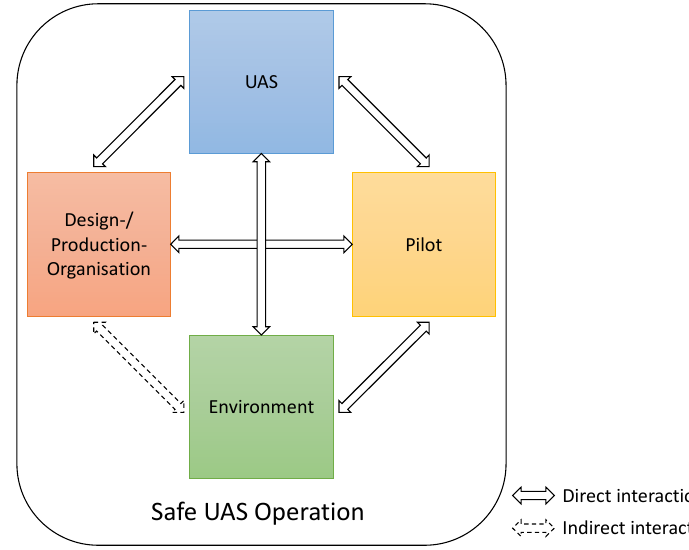
Figure 1. Aspects and their interactions affecting safe UAS operation.